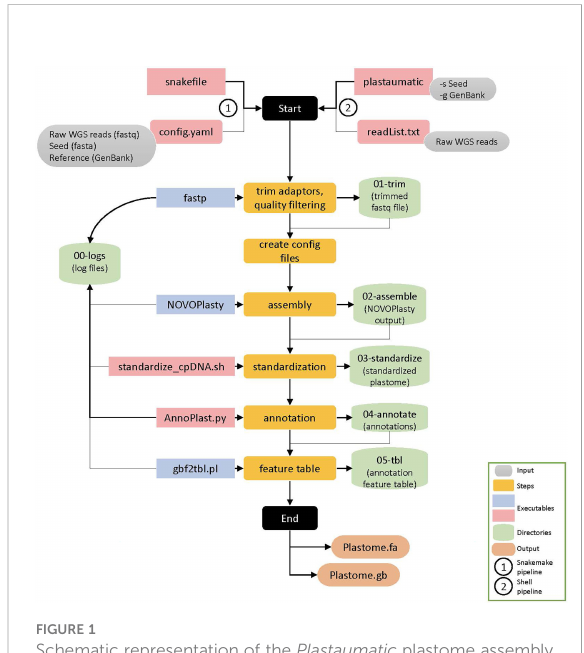
FIGURE 1 Schematic representation of the Plastaumatic plastome assembly pipeline with details. There are six steps involved in the Plastaumatic pipeline i.e., trimming, creating con fi g fi le for assembly, de novo assembly, standardization, annotation, and generating a feature table fi le. The pipeline can be run using Snakemake or a shell script, both of which produce the same output. The input data required for the Plastaumatic is the raw WGS reads in fastq format, a seed fi le in fasta format, and an annotation fi le in GenBank format. The pipeline creates multiple directories as detailed in the fi gure to store all the